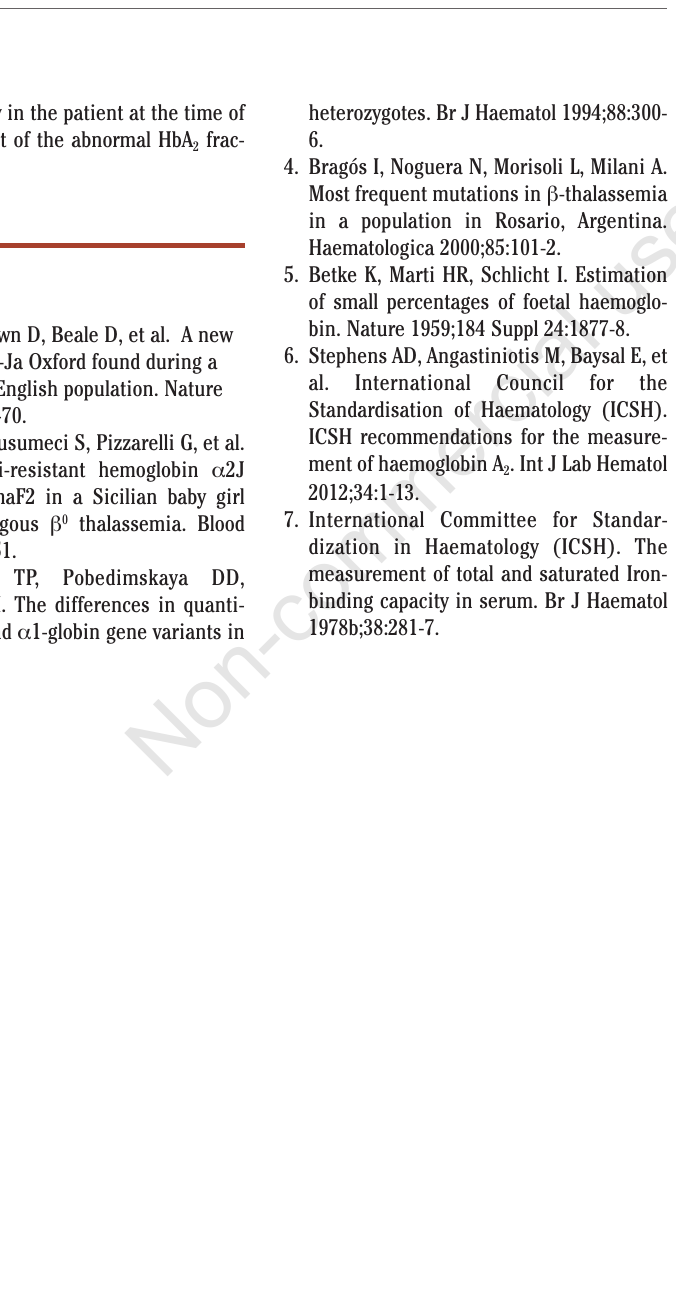
Figure 1. A) Hemoglobin electrophoresis at alkaline pH. B) Sequencing of the a 1-globin gene showed one mutation corresponding to Hb Interlaken (Hb J-Oxford, Hb N- Cosenza), [ a 15Gly → Asp,